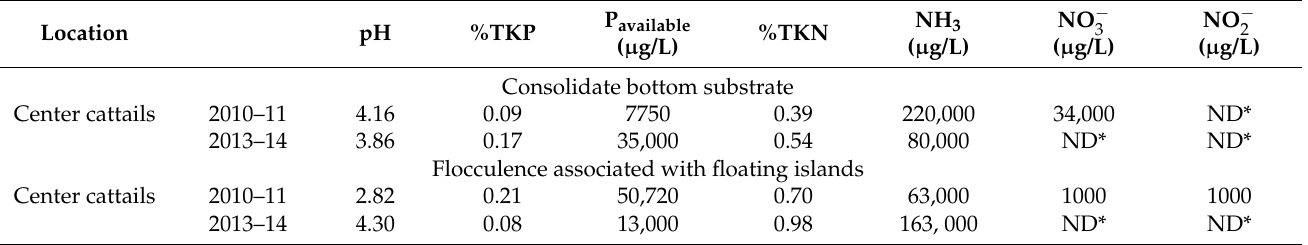
Table 2. Analysis for consolidated bottom substrate and flocculence from the center mat and cattail (Typha domingensis) areas in the